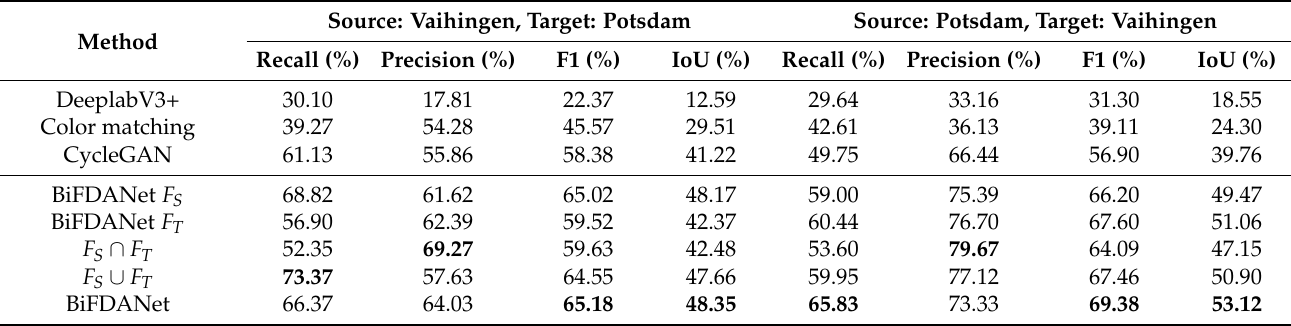
Table 3. Comparison results on ISPRS dataset. The best values are in